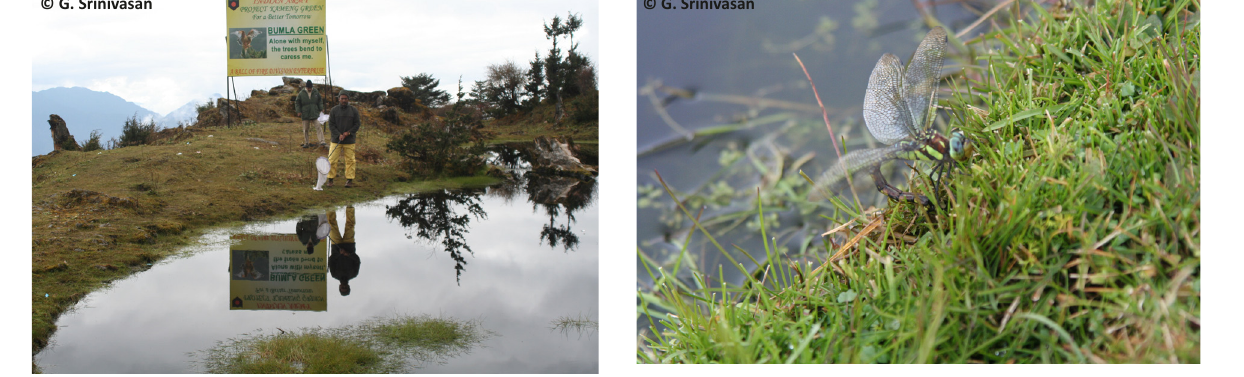
Image 2. Collection locality and habitat of Aeshna